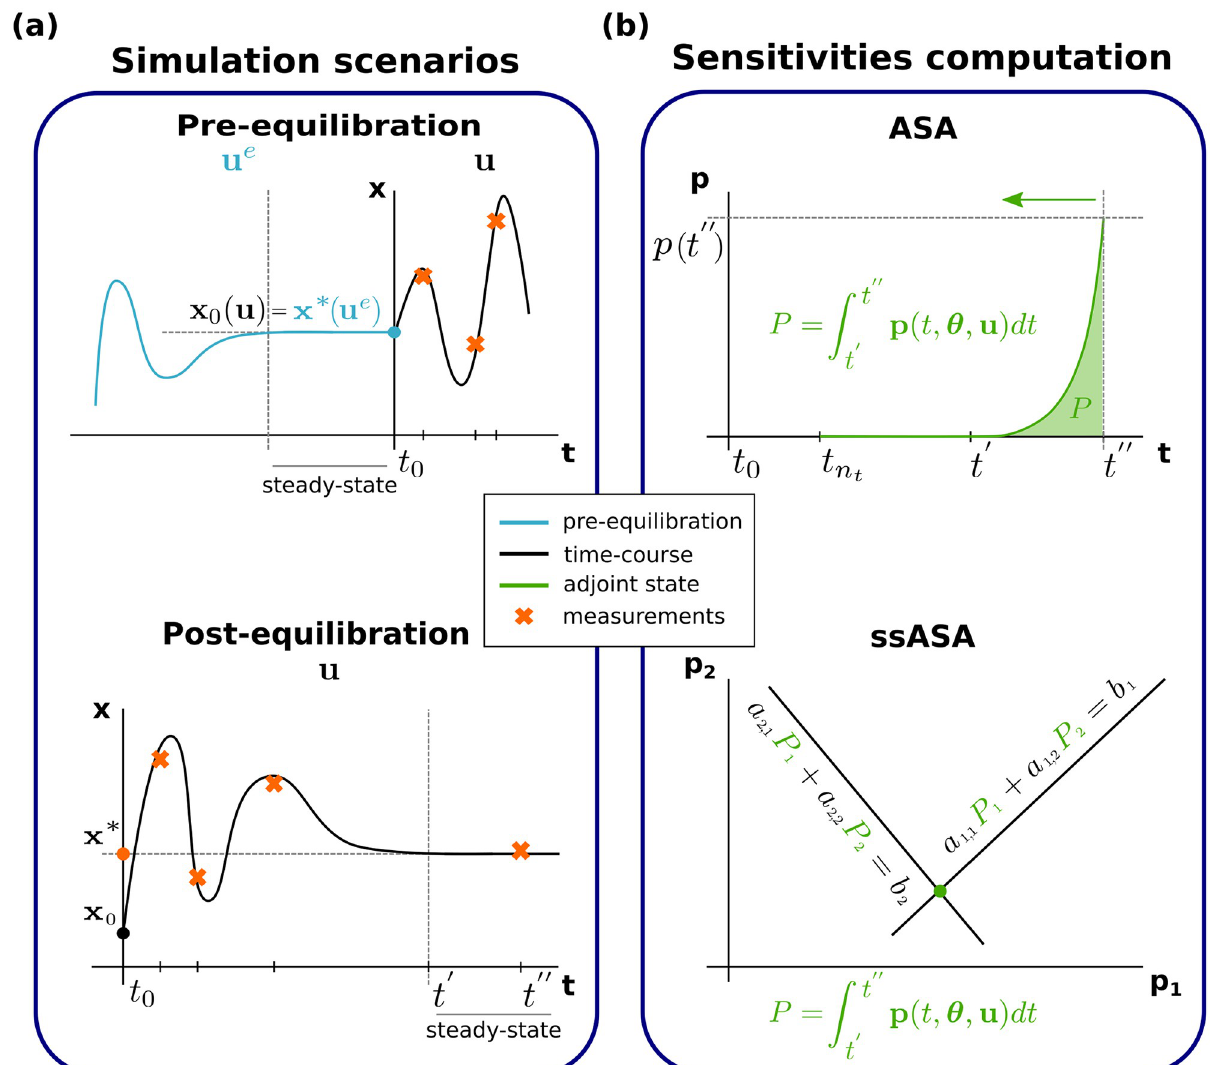
Fig 1. Steady-state simulation scenarios, and computation methods for ASA. (a) Different scenarios requiring computation of the model steady state. Top: The pre-equilibration case, where the system is at steady state at the beginning of the experiment. This means that by t = t 0 the system has reached its steady state ( x � ) under some condition ( u e ) (blue line). At t = t 0 the system was perturbed and measurements were taken at time points t t 0 (orange crosses). The pre-equilibration steady state ( x � ) is the initial state under the experimental conditions ( u ), i.e. x 0 ( u ) = x � . Bottom: The post- equilibration case, where at some point after the beginning of the experiment, the system reaches its steady state ( x � ) and measurements for this time point ( t = t 00 ) are available (orange cross at t = t 00 ). Measurements of the transient state may also be available (orange crosses in t < t 00 ). (b) Alternative approaches for computing sensitivities. Top: The standard ASA approach that requires numerical integration until convergence to the steady state and subsequent backward integration of the adjoint state ( p ) ODE on the same time interval. Bottom: The proposed adjoint method that circumvents backward numerical integration and requires solving a system of linear algebraic equations instead.